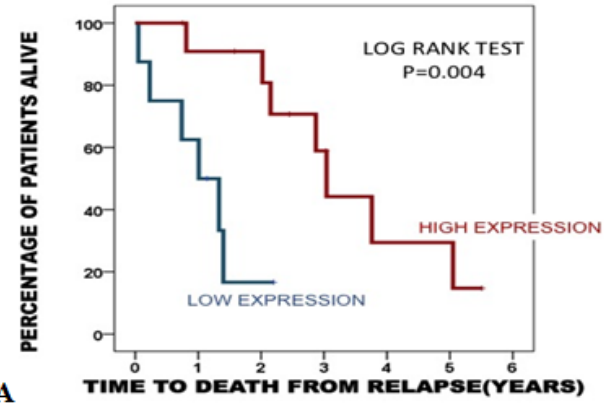
Figure 5. ( A ) Kaplan Meier plot demonstrates that in patients with low proliferating tumours (8 patients), high pAR 791 expression (12 patients) is significantly associated with longer time to death from disease recurrence than those with low pAR 791 expression; ( B ) Kaplan Meier plot demonstrates that in patients with high proliferation tumours, pAR 791 expression is not associated with time to death from disease recurrence (low expression 11 patients, high expression 12